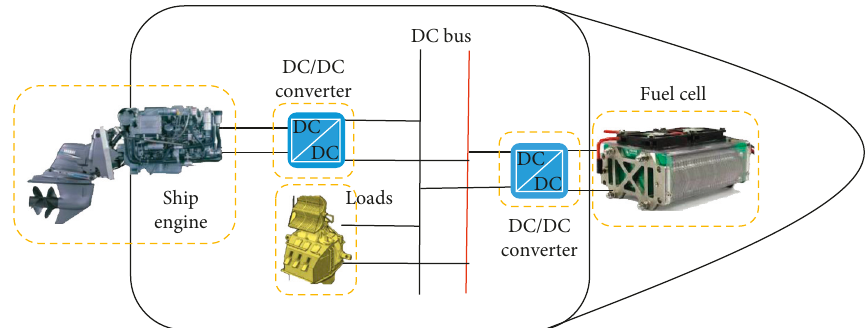
Figure 1: The overall scheme of the stand-alone DC zero-emission ferry ships. Table 1: The parameters of the DC marine